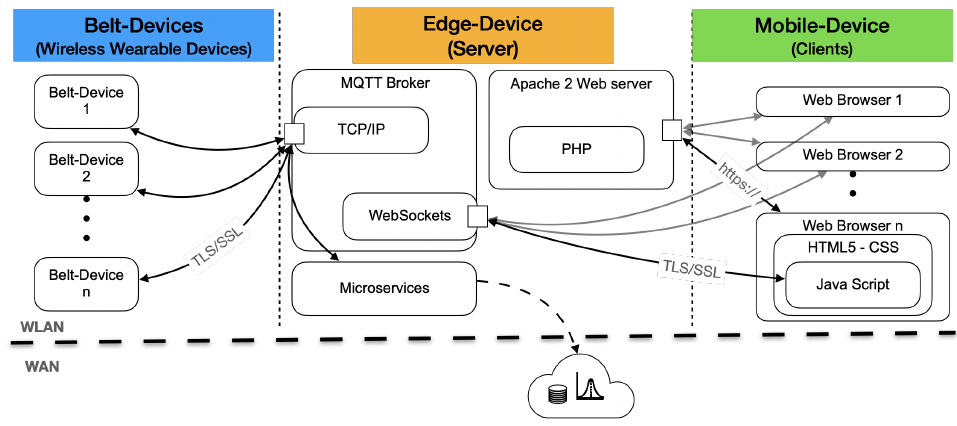
Figure 15. System software